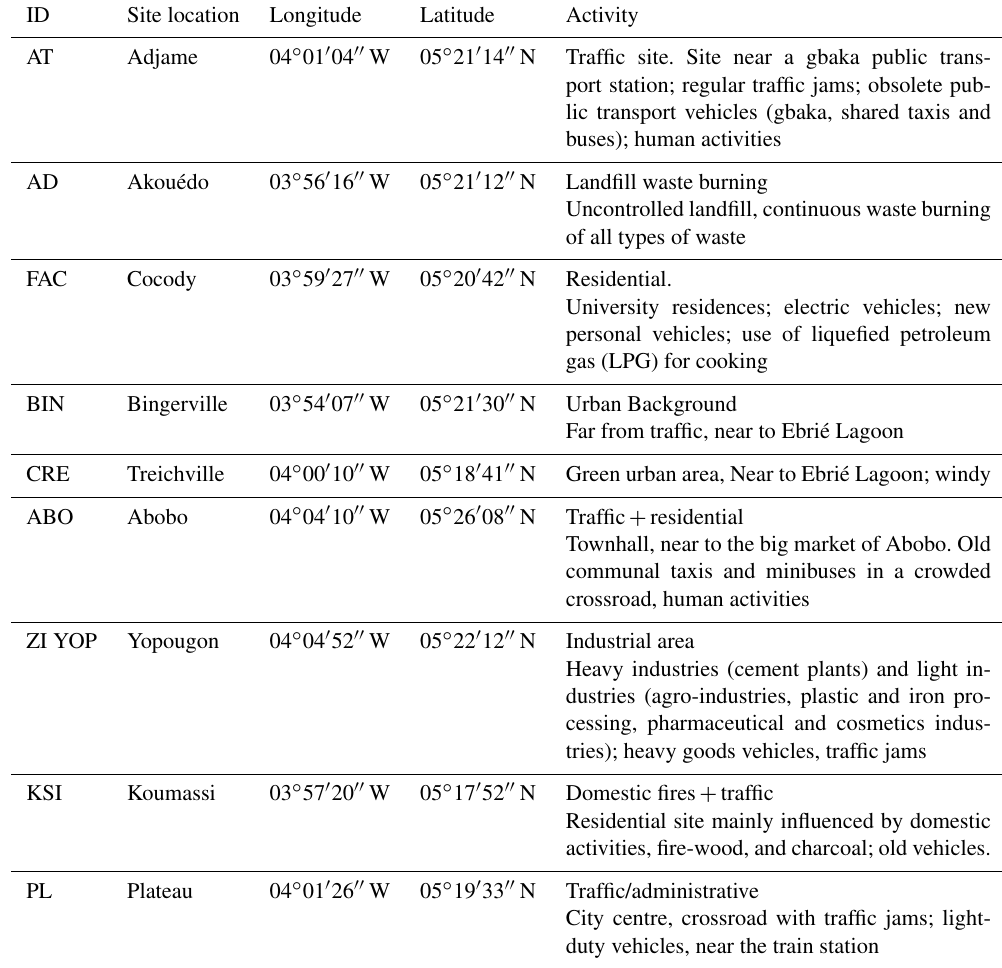
Table 2. Geographical location and characteristics of ambient measurement sites in Abidjan, Côte